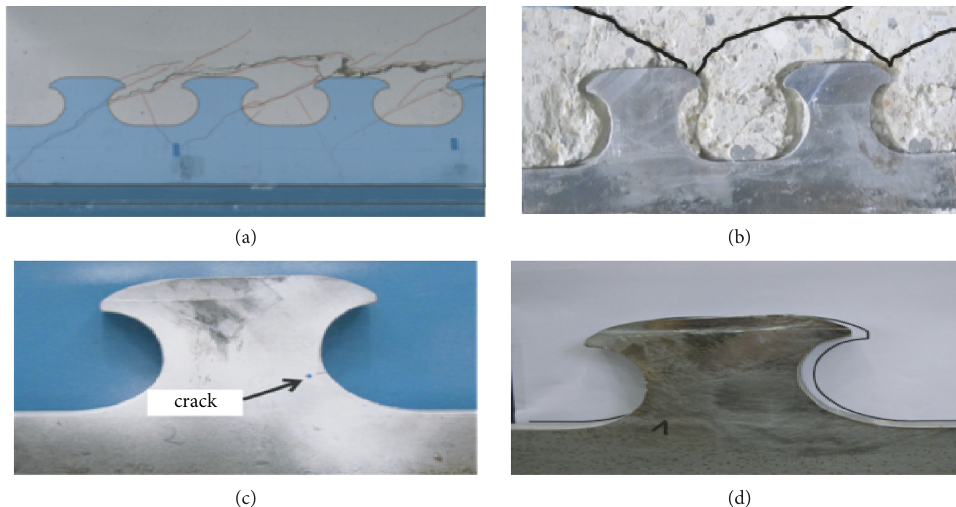
Figure 18: Failure mode of concrete dowel shear connector [69]. (a) Shear failure, (b) concrete pry-out failure, (c) steel failure, and (d) plastic